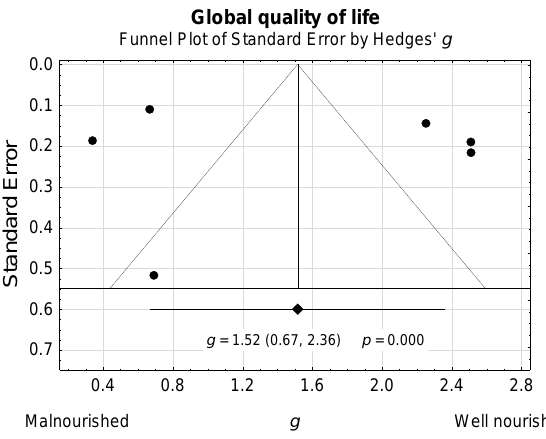
Figure 3. Funnel plot for visual assessment of the probability of systematic bias due to selective publication of studies.